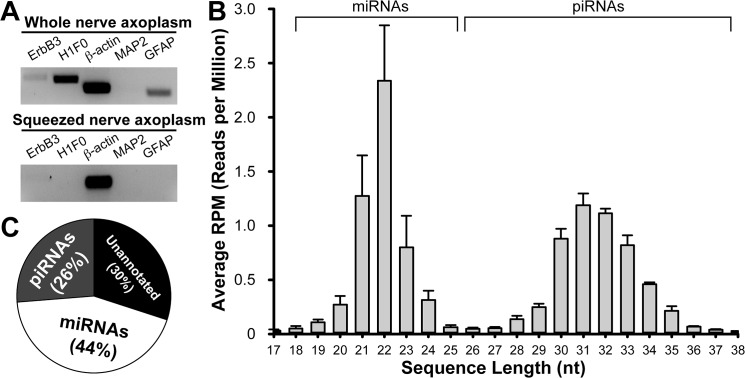
Enrichment and detection of small non-coding miRNA from sciatic nerve axoplasm.
A. Extended RT-PCR of mRNAs from sciatic nerve axoplasm using either by the conventional whole tissue lysate method or a mechanical squeezing procedure. Note that neither cell body restricted (MAP2, H1F0) nor glial (GFAP, ErbB3) mRNAs were amplified from sciatic nerve cDNAs reverse-transcribed from the squeezed axoplasmic RNAs. B. Size and frequency distribution of regulatory and small non-coding RNAs in uninjured sciatic nerve. C. A size histogram of mapped small RNAs. >40% of small RNAs were mapped to miRNAs, while 30% of small RNA sequences could not be annotated.